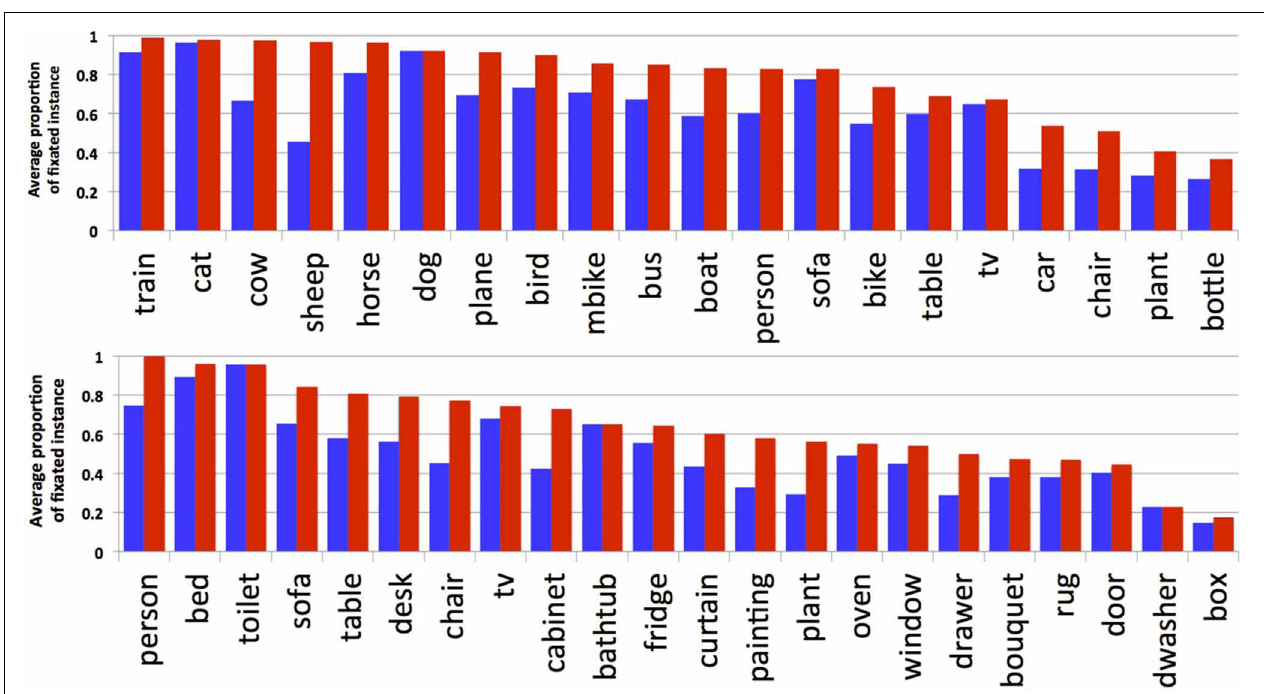
FIGURE 5 | Proportion of fixated categories. Blue bars show the average proportion of fixated instances per category. Red bars show the percentage of images where a category was fixated when present (at least one fixated instance in an image).